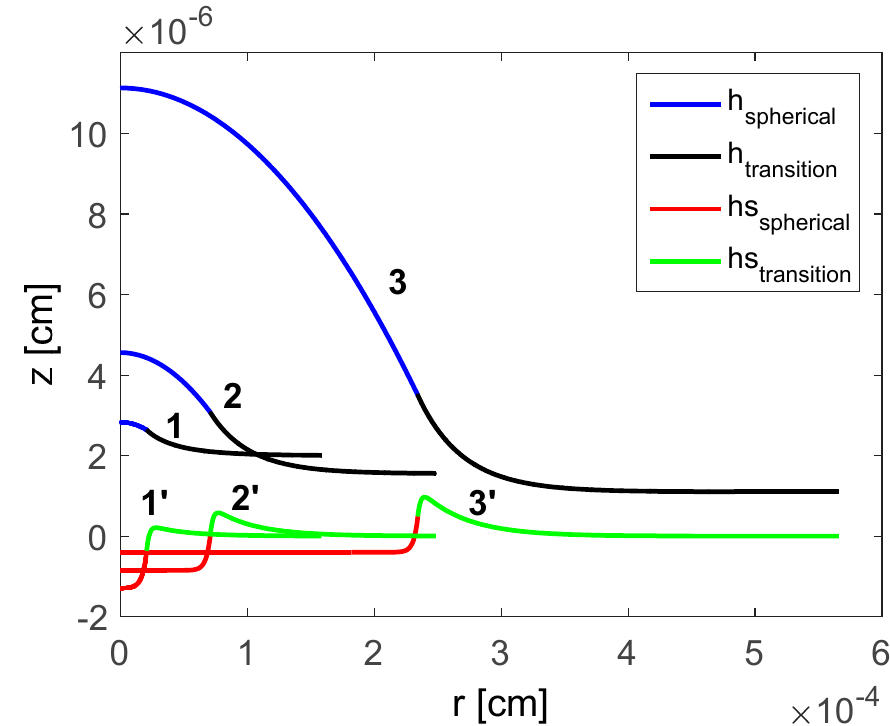
Figure 3 . Computed shapes of the droplet and deformation of the substrate: 1,1 (cid:4593) − |𝑃 (cid:3032) | = 130,000 Figure 3. Computed shapes of the droplet and deformation of the substrate: 1,1 (cid:48) − | P e | = 130,000 dyne/cm 2 ; dyne/cm 2 ; 2,2 (cid:4593) − |𝑃 (cid:3032) | = 85,000 dyne/cm 2 ; and 3,3 (cid:4593) − |𝑃 (cid:3032) | = 40,000 dyne/cm 2 [18]. Reproduced with 2, 2 (cid:48) −| P e | = 85,000 dyne/cm 2 ; and 3, 3 (cid:48) −| P e | = 40,000 dyne/cm 2 [18]. Reproduced with permission from [18]. Copyright © 2017 Elsevier